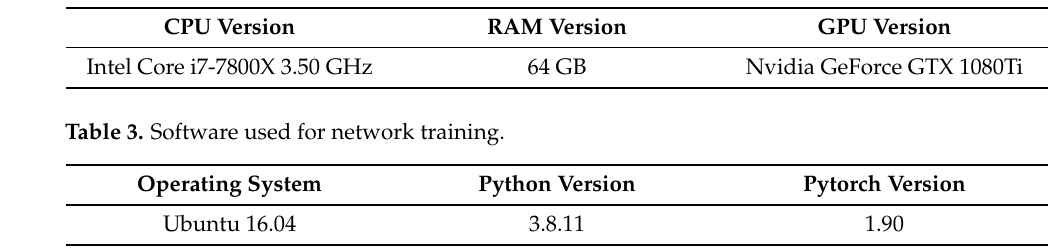
Table 2. Hardware used for network training.